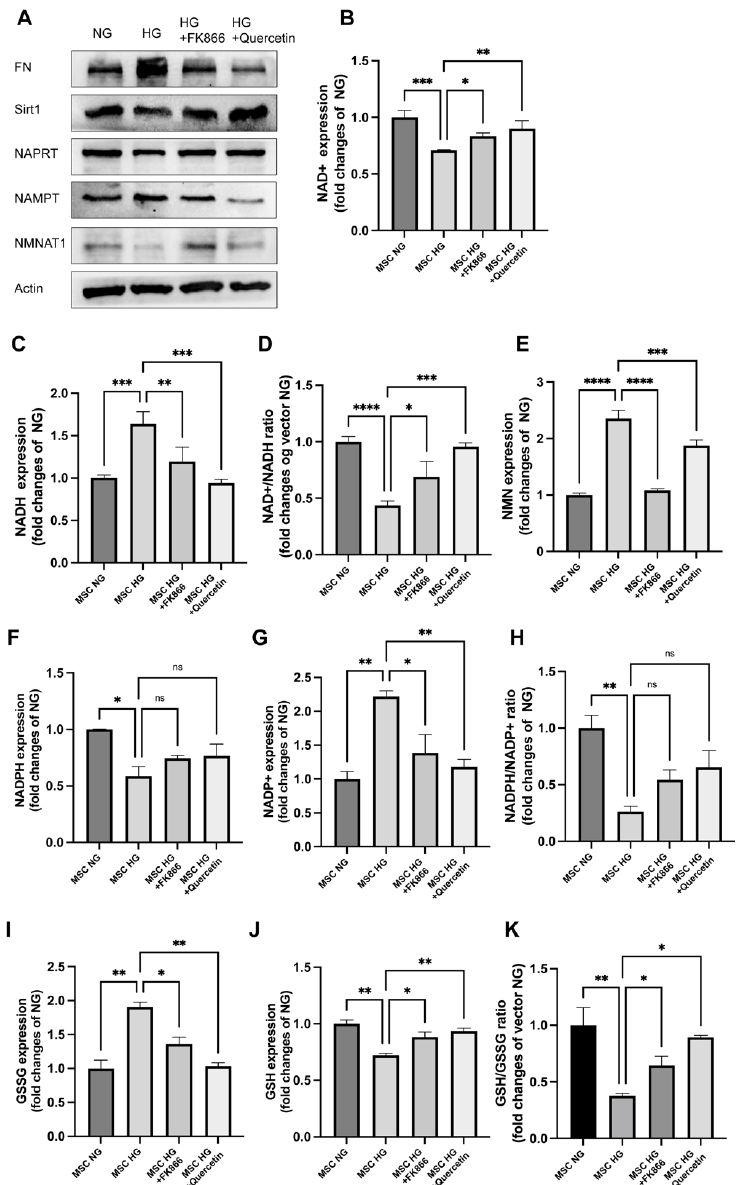
Figure 3. FK866 and quercetin protected against MSC injury and improved NAD + anabolism under HG: ( A ) Western blot analysis of NAD-related enzymes and fibrotic injury incubated with FK866 (50 nM) or quercetin (20 μ M) 24 h after 24 h HG in MSC for FN, NAMPT, NAPRT, and